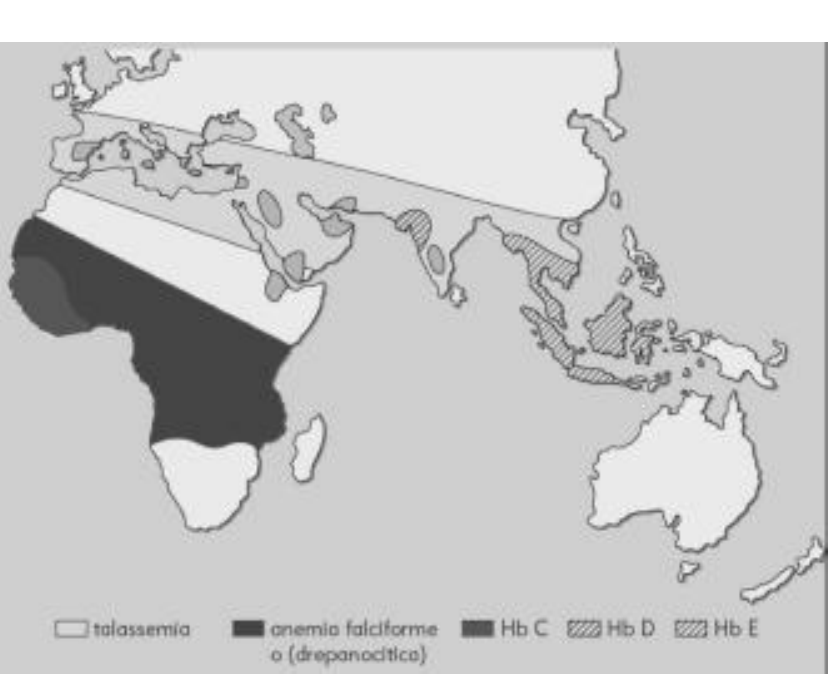
Figura 1. Distribuzione geografica delle